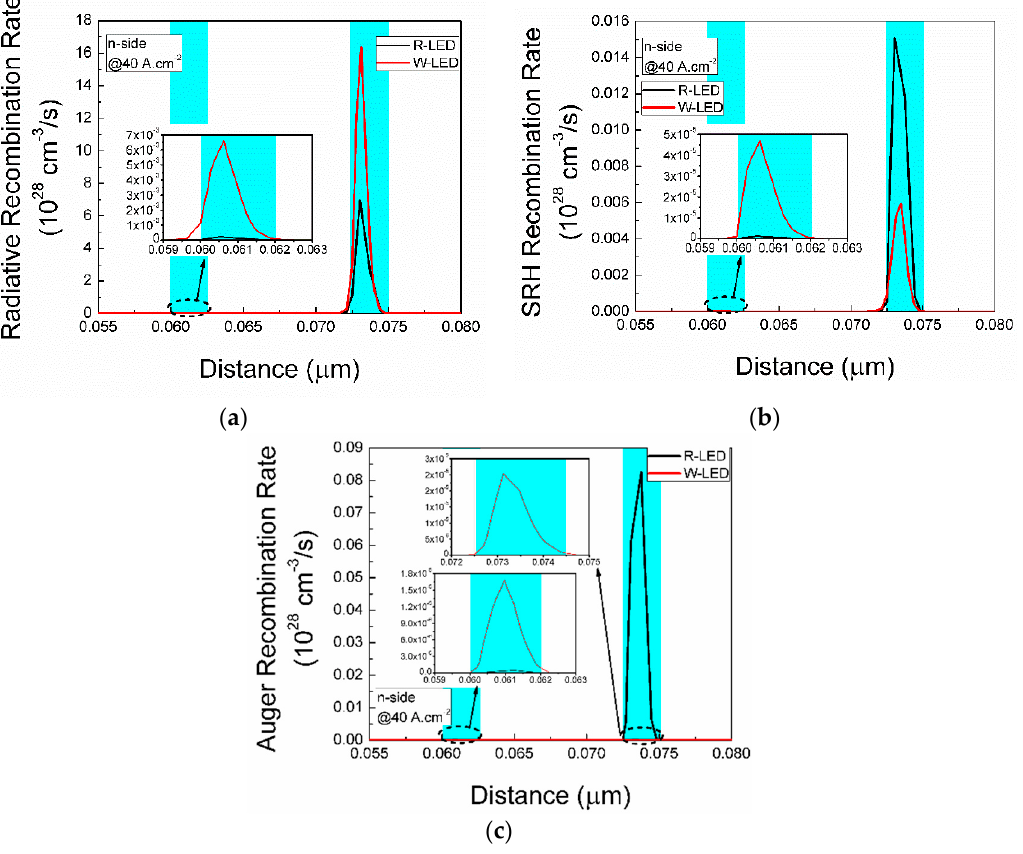
Figure 4. Comparison of recombination rates in the two devices: ( a ) Radiative; ( b ) Shockley-Read-Hall (SRH); and, ( c ) Auger. Insets show the magnified recombination rates.